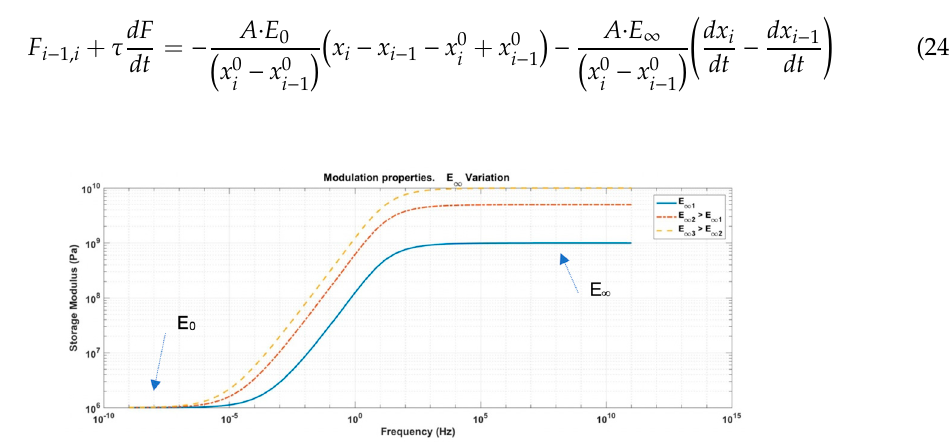
Figure 15. H-N model. Storage Modulus variation with Frequency. E ∞ unrelaxed modulus.